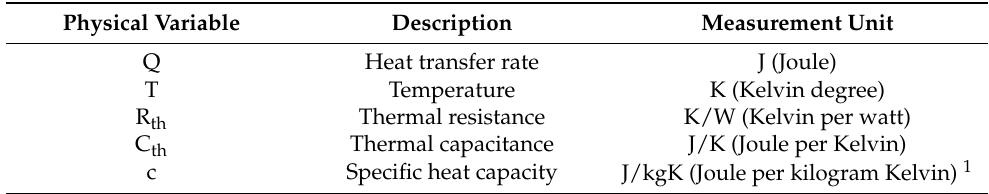
Table 1. Electrical to thermal domain